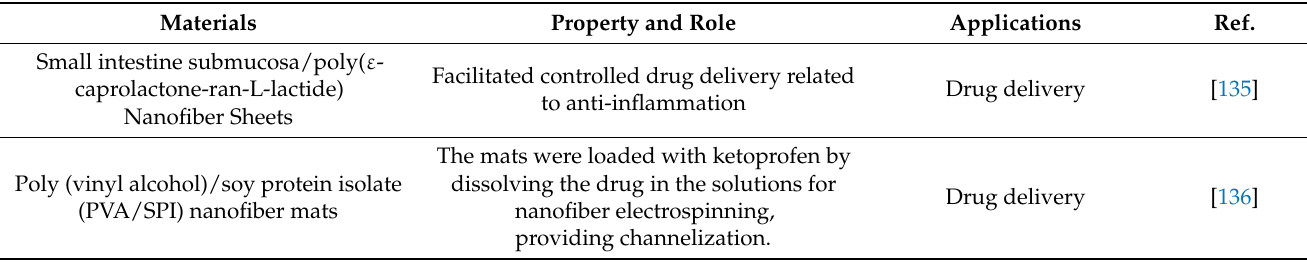
Table 3. Role of nanofiber materials in various drug delivery